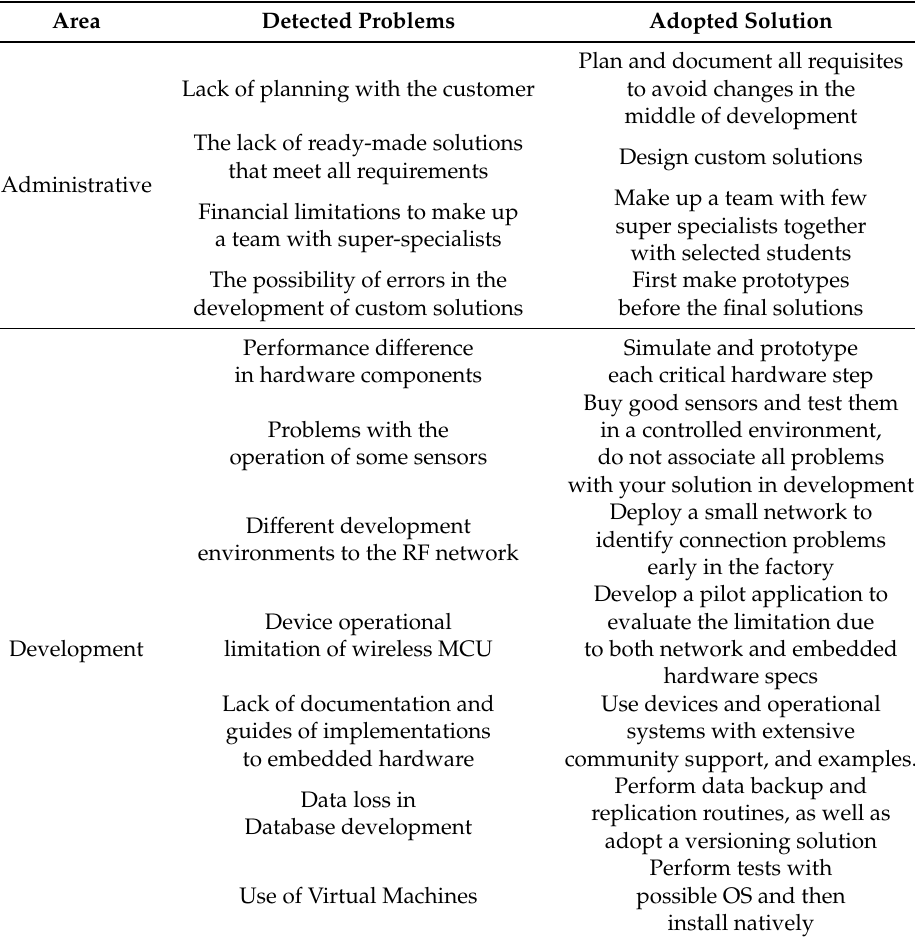
Table 2. Lessons learned and their